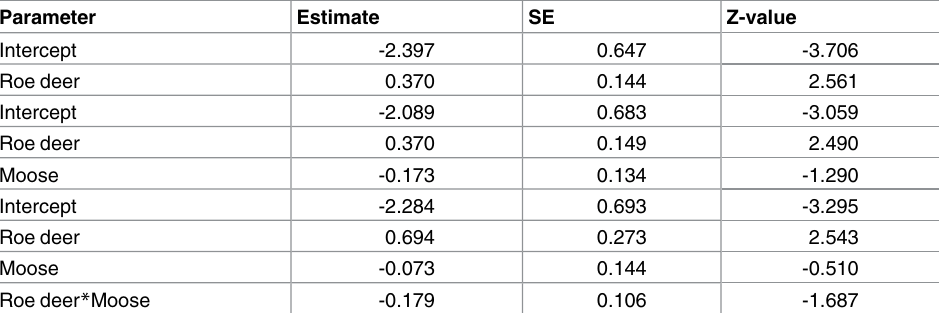
Table 3. Parameter estimatesafter model averaging from the most parsimonious models ( Δ AICc < 4, Table 2) predicting the selection of roe deer (1) over moose (0) as kills for wolves in Scandinavia, in relation to roe deer density (Roe deer) and moose density